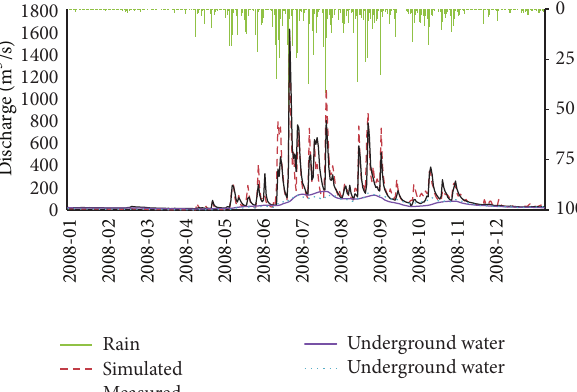
Figure 7: XAJ model validation phase (2008). Measured and simu- lated discharge, the groundwater runoff separated from the hydro- graph and calculated by Xin’anjiang model, and catchment average rainfall time